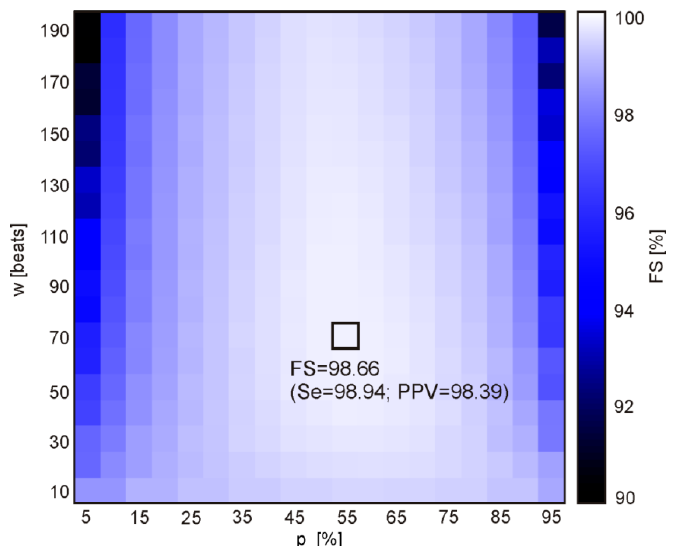
Figure 6. The distances of points defined by (Se( w, p ), PPV( w, p )) to the point of the highest values (100%, 100%), obtained for the 361 combinations of the following validation criteria: window width w = {10, 20,…,190} and percentage threshold p = {5, 10,…, 95}. The brightest rectangle indicates the maximum FS (the highest algorithm performance) determined for a given combination ( w, p ).